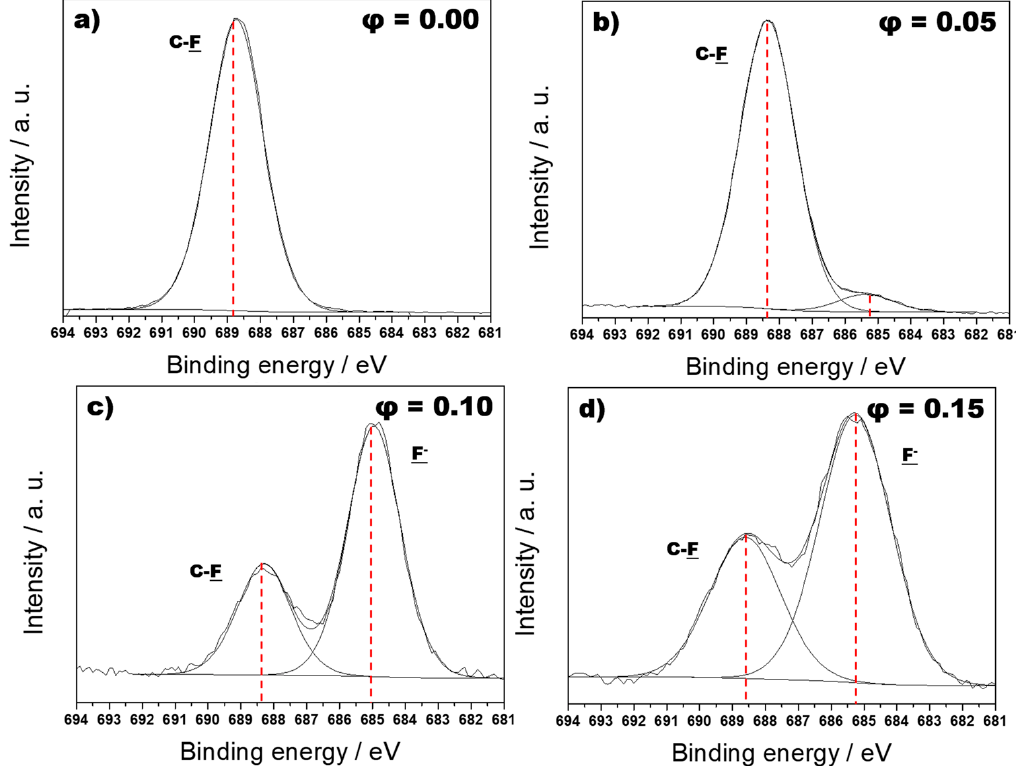
Figure 3. F1s XP-high resolution regions of ZnO-CF x nanocomposites having an inorganic phase volume fraction φ = 0 ( a ), φ = 0.05 ( b ), φ = 0.10 ( c ), and φ = 0.15 ( d ).